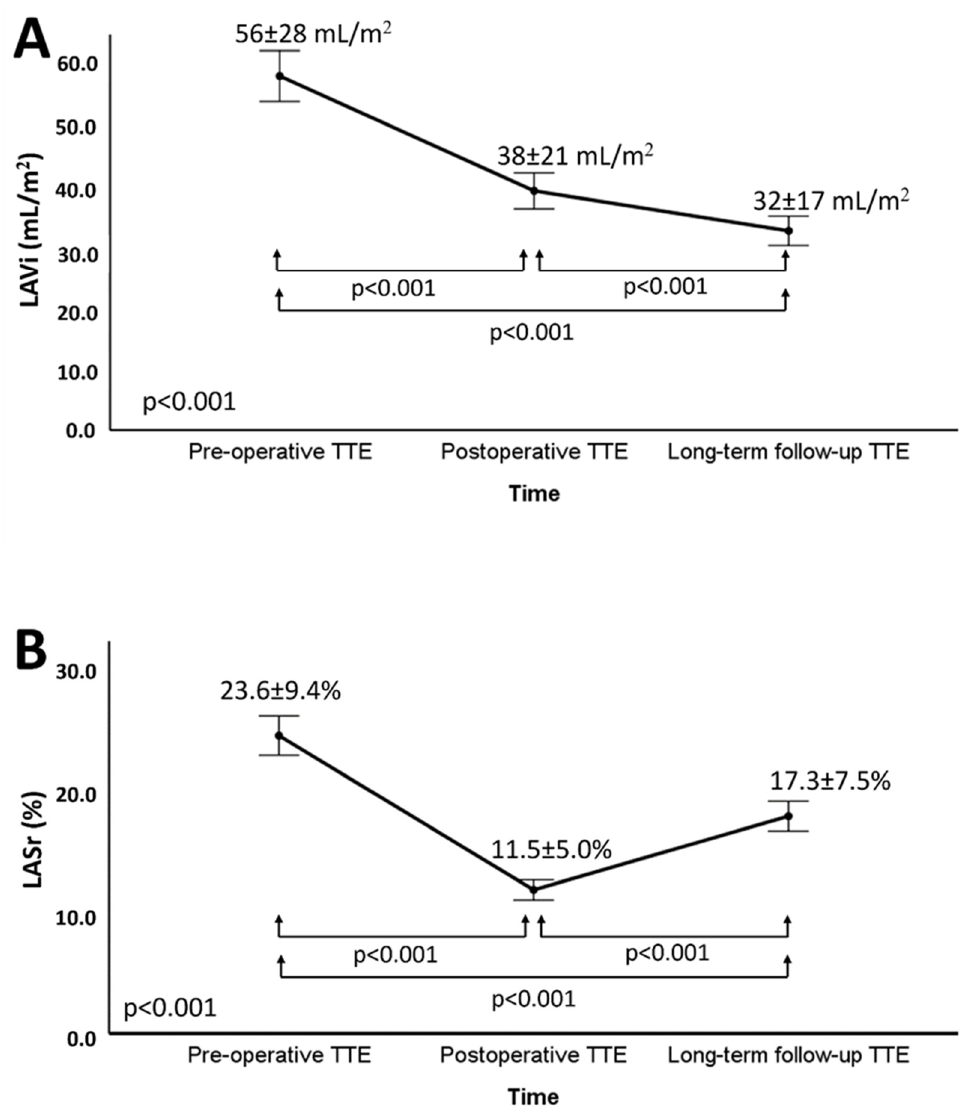
Figure 2. Changes in left atrium volume index ( A ) and left atrium reservoir strain ( B ) over time. Panel A shows the changes in LAVi among baseline, postoperative, and long-term follow-up values. Panel B shows the changes in LASr among baseline, postoperative, and long-term follow-up values. LASr = left atrial reservoir strain; LAVi = left atrium volume index; TTE = transthoracic echocardi- ography.